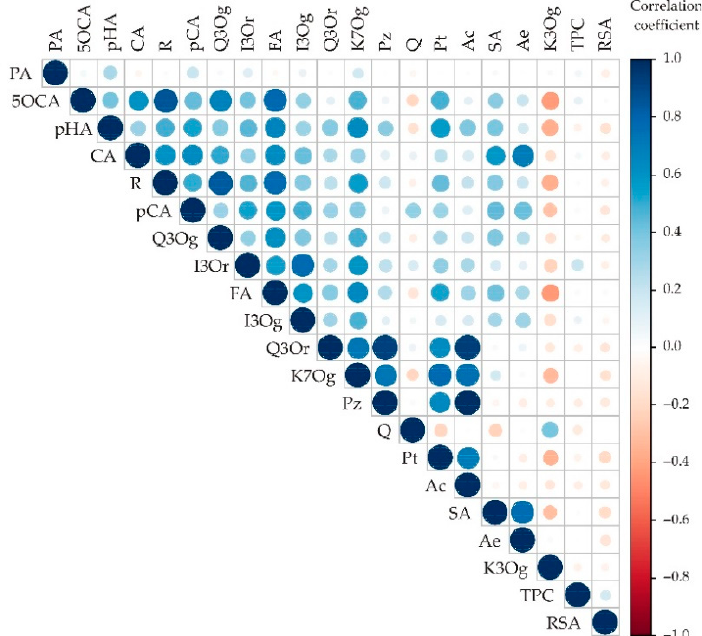
Figure A4. Color correlation graph between phenolic content in plum samples (PA—protocatechuic